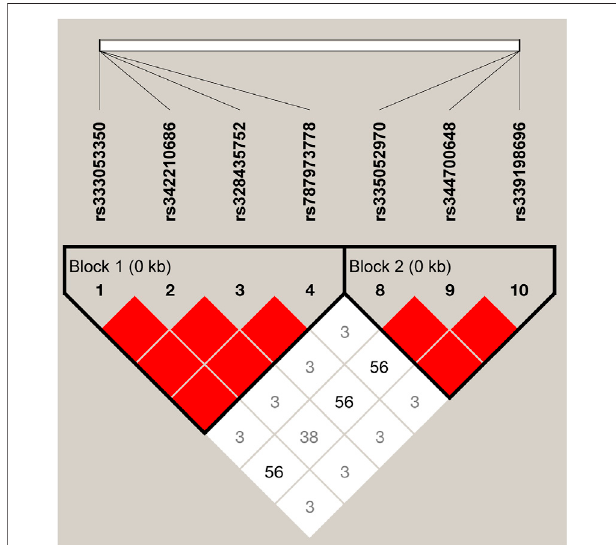
FIGURE 2 | LD among the SNPs in the porcine ARHGAP24 gene (D ’ = 0.03 – 1.00). It is to be noted that the blocks indicate haplotype blocks and the text before the horizontal numbers is the SNP name. The values in boxes are pairwise SNP correlations (D ’ ), while bright red boxes without numbers represent complete LD (D ’ =